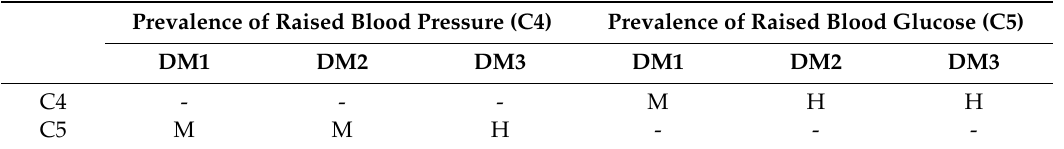
Table 6. Linguistic evaluations of decision makers for the dimension of non-communicable diseases.